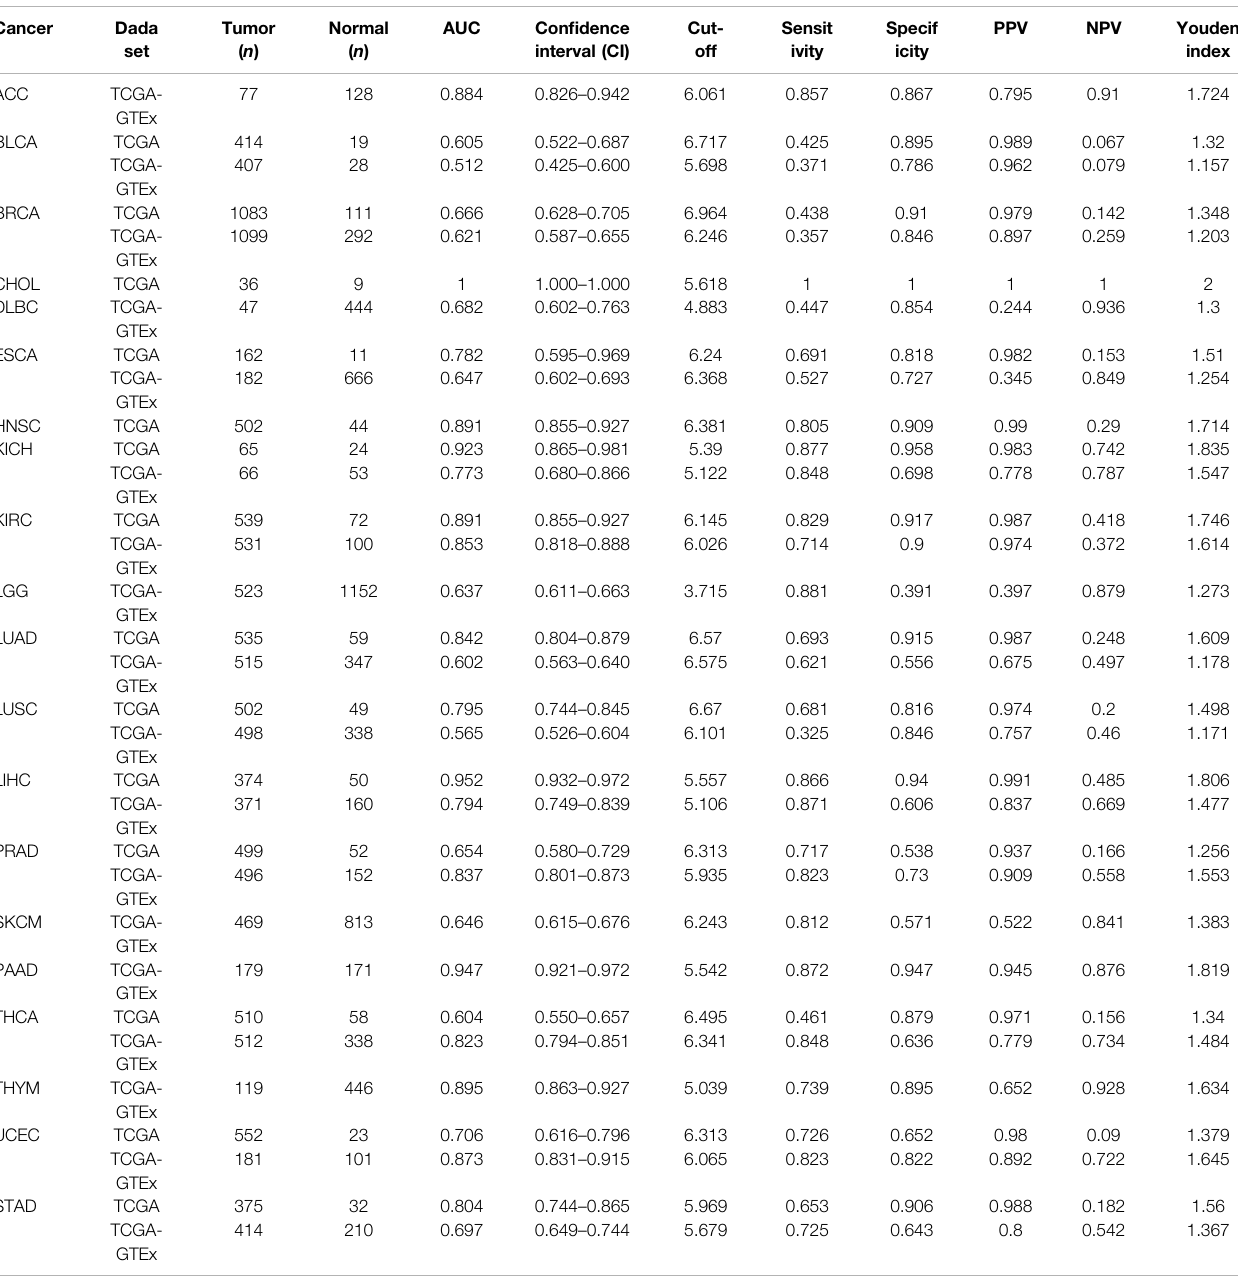
TABLE 4 | The diagnostic value of SHC1 for